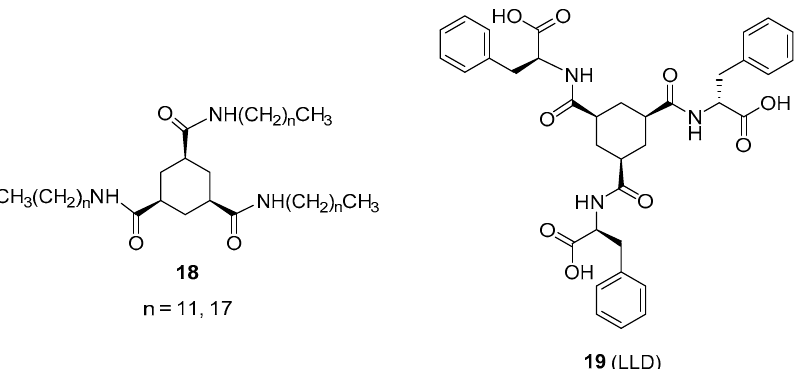
Figure 13. Structures of 1,3,5-cyclohexanetricarboxamide-based organogellators 18 and hydrogelator 19 (LLD).